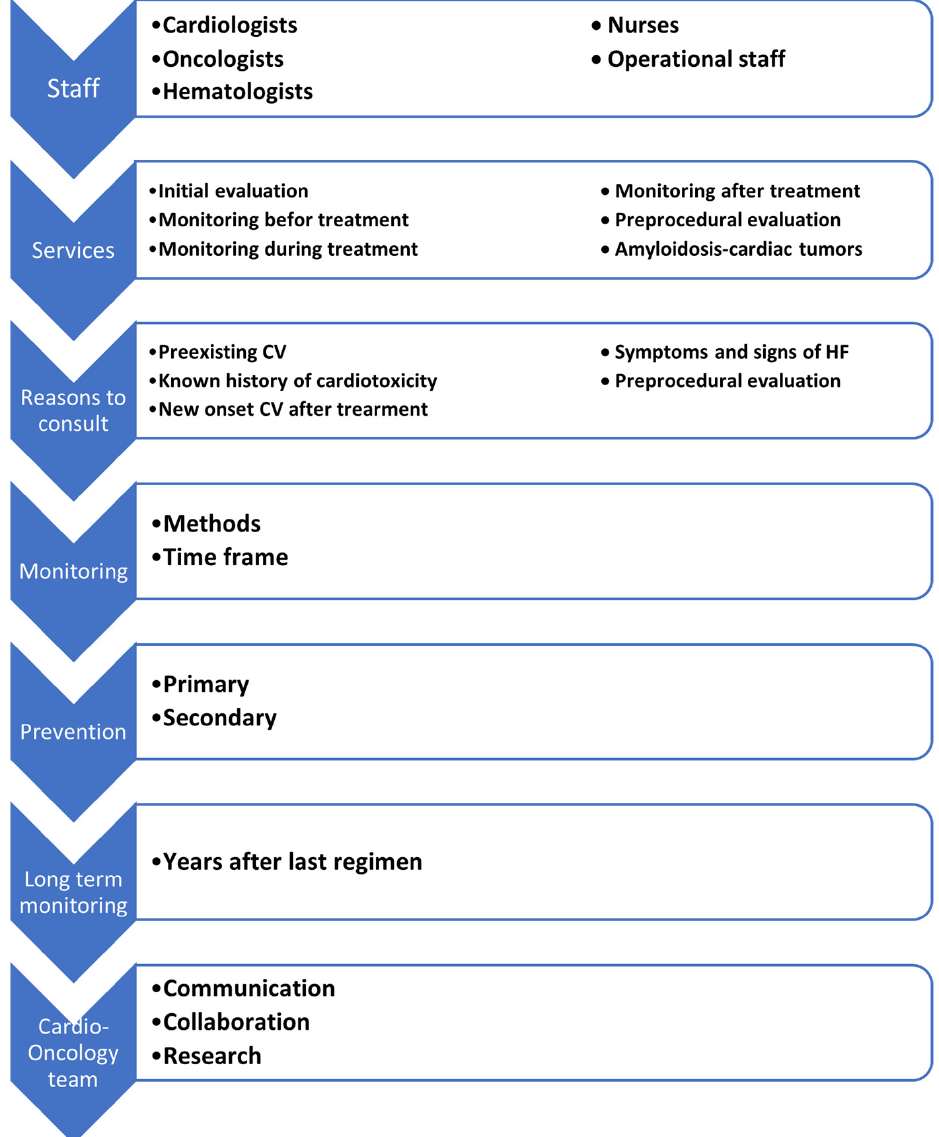
Figure 2. Steps in planning and developing a cardio-oncology clinic.